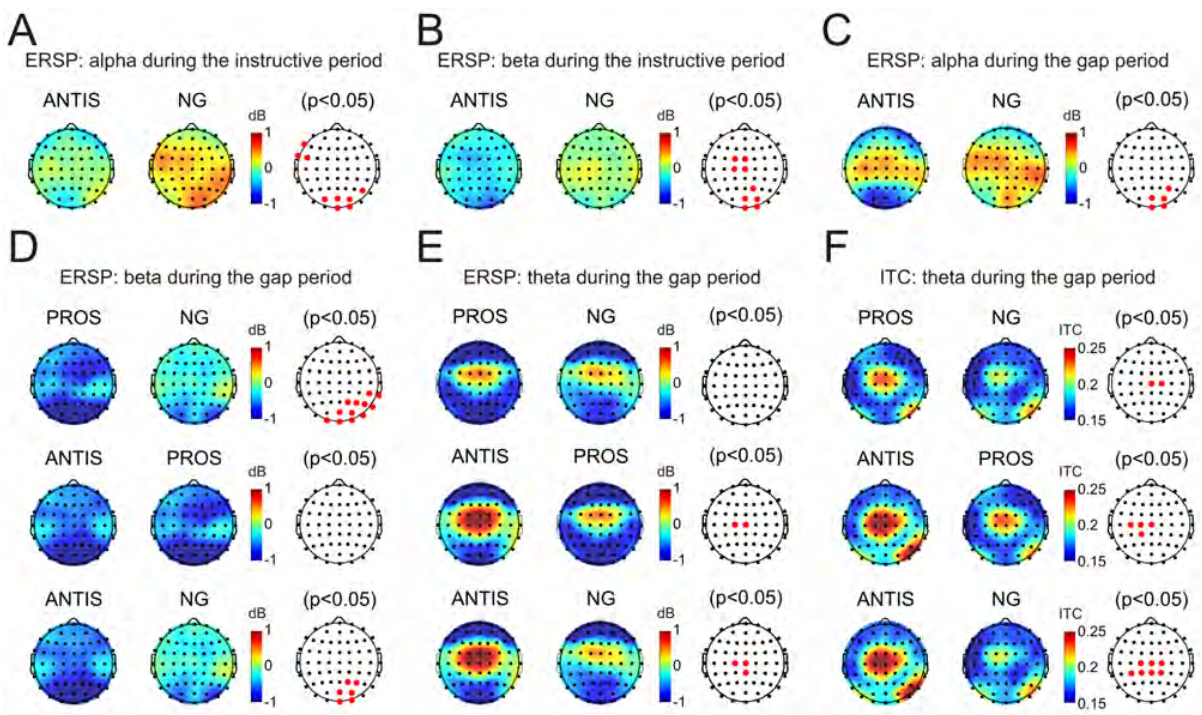
Figure 7. Topographical distribution of theta, alpha and beta rhythm activities during the instructive and gap periods. A and B show scalp distribution of event-related spectral power (ERSP) in alpha and beta bands, respectively, during the instructive period. Comparisons between tasks (third column) showed a significant event-related synchronization (ERS) in no-go (NG) with respect to antisaccadic (ANTIS) task in the alpha band (A), and an event-related desynchronization (ERD) for antisaccadic compared to no-go task in the beta band (B). C–F show the scalp distribution of ERSP and inter-trial phase coherence (ITC) during the last 270 ms of the gap period. Parieto-occipital regions were characterized by a significant alpha ERD in antisaccadic with respect to no-go tasks (C) and a beta ERD higher in antisaccadic and prosaccadic than in no-go tasks (D). Fronto- central activities were depicted by theta ERS and ITC. Theta ERS was higher in antisaccadic than prosaccadic and no-go tasks (E). Theta ITC task comparisons showed best phase locking in antisaccadic followed by prosaccadic and no-go tasks (F). Red points in the third column indicate significant differences (p , 0.05). Calibration bars are indicated.